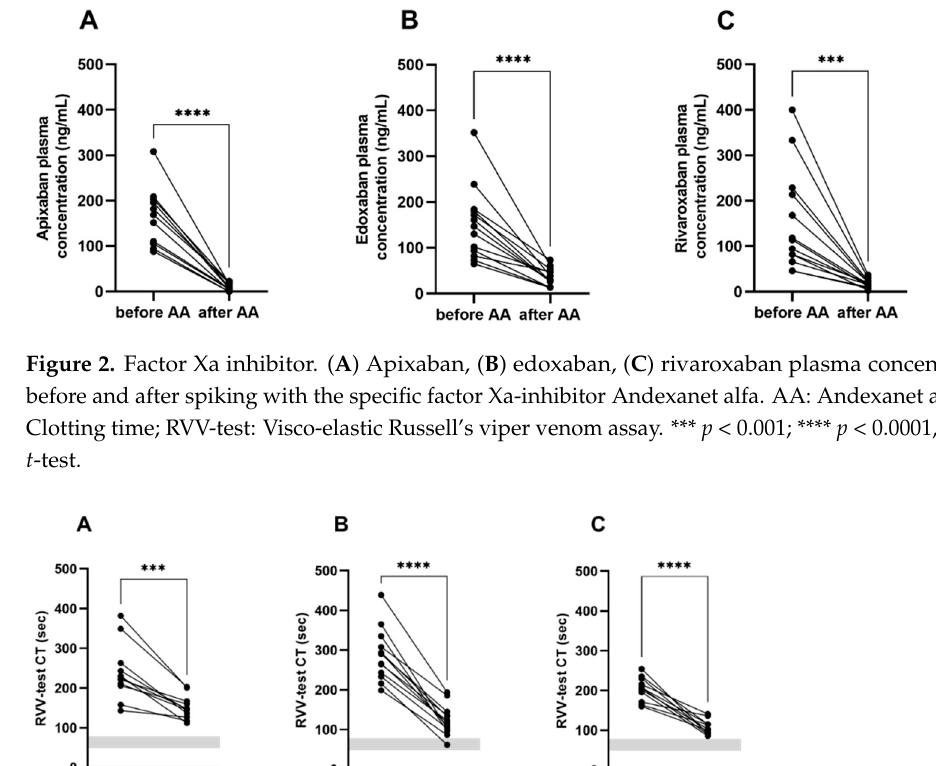
Figure 2. Factor Xa inhibitor. ( A ) Apixaban, ( B ) edoxaban, ( C ) rivaroxaban plasma concentration before and after spiking with the specific factor Xa-inhibitor Andexanet alfa. AA: Andexanet alfa; CT: Clotting time; RVV-test: Visco-elastic Russell’s viper venom assay. *** p < 0.001; **** p < 0.0001, paired t -test.